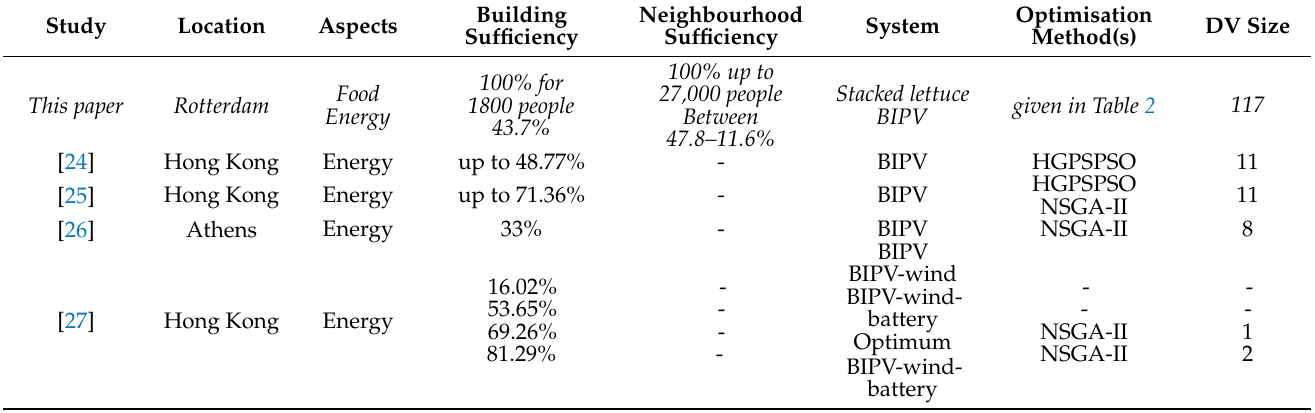
Table 1. Overview of previous